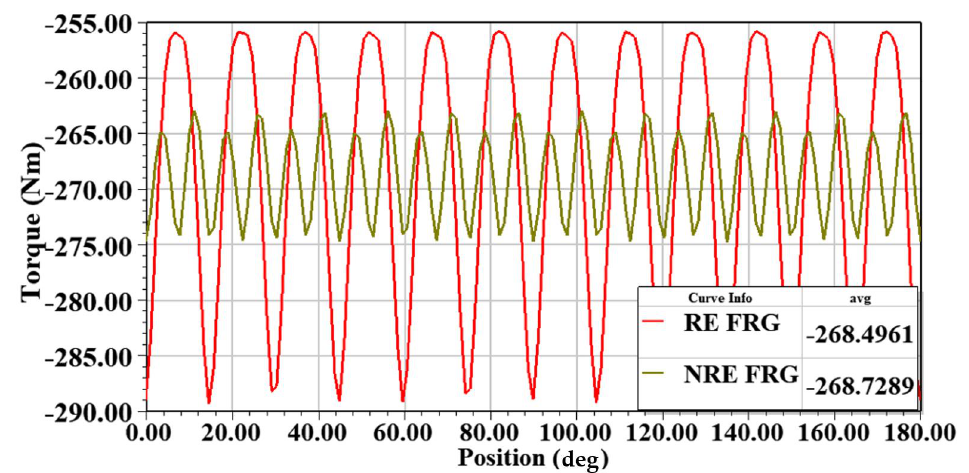
Figure 10. Comparison of torque ripple effect under load.